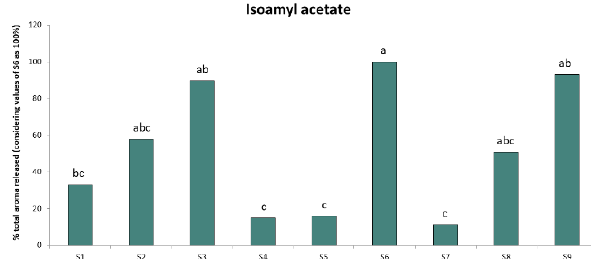
Figure 3. Mean values (%) of isoamyl acetate released for each of the volunteers by PTR-ToF-MS. Data represent the total AUC values for isoamyl acetate determined in the subjects and are expressed in percentage (considering the values obtained for the S6 as 100% and comparing this value with the amount determined for the rest of the subjects). Different letters denote statistical significant differences ( p < 0.05) from Tukey